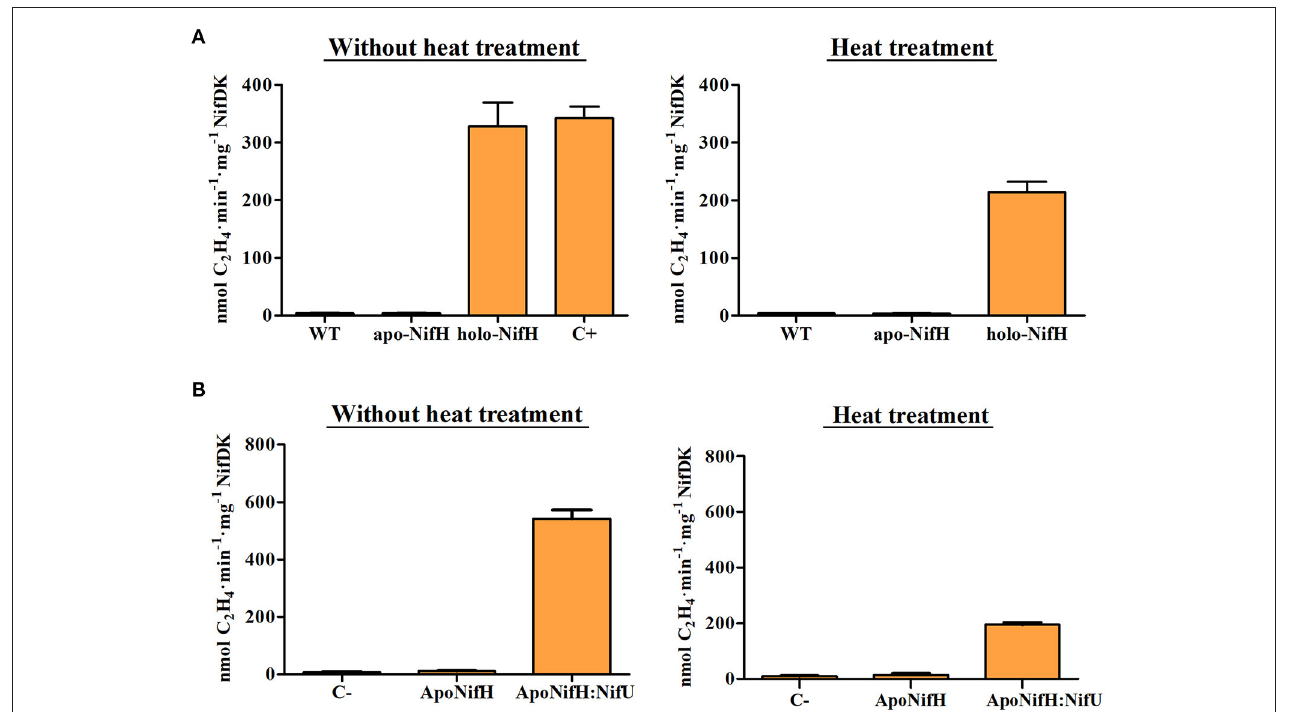
FIGURE 5 | Reconstitution of apo-NifH added to tobacco protein extracts. (A) Pure apo-NifH and NifH (holo-NifH) isolated from A. vinelandii were mixed with tobacco WT tobacco protein extracts without a heat treatment (left) or subjected to heat treatment (right). NifH activity was determined by ARA using 9:1 molar ratio of NifH:NifDK. WT, control reactions containing only WT tobacco leaf extract. C + , control reactions including the same amount of holo-NifH but lacking WT tobacco protein extracts. Average activities ± SD ( n = 4) are shown. (B) Reconstitution of apo-NifH by NifU added to WT tobacco total protein extracts without (left) and with (right) heat treatment. Pure A. vinelandii apo-NifH was mixed with WT tobacco leaf extracts and then, [Fe-S] cluster-loaded NifU was added to the mixtures. After 10min incubation at room temperature, pure NifDK was added and samples were analyzed for ARA. C-, WT tobacco leaf extracts without added NifH. Average activities ± SD ( n = 4) are